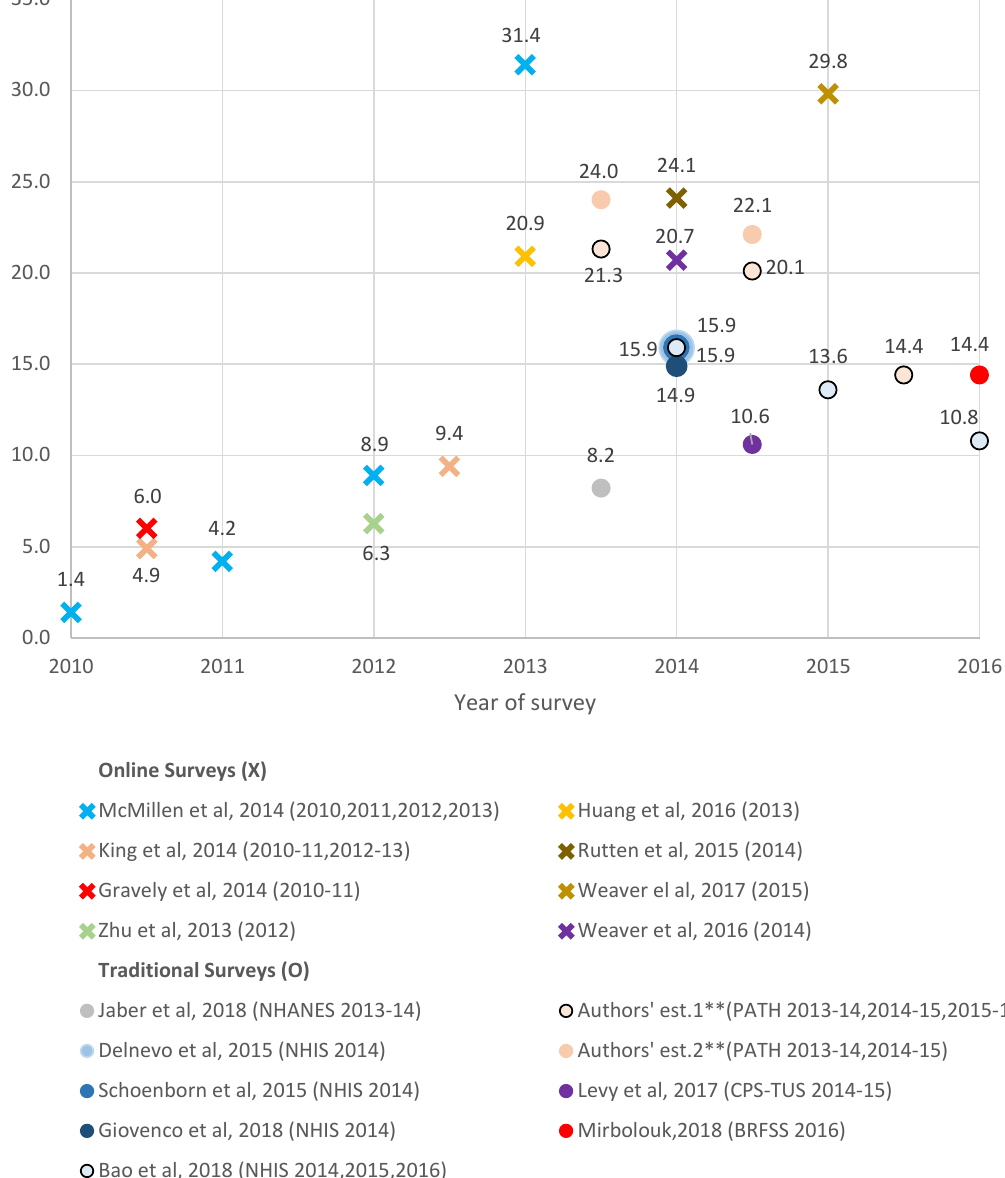
Figure 2. The prevalence of current e-cigarette / ENDS use among adult current smokers, online and traditional survey estimates *, 2010–2016. * The estimates from online surveys are indicated by an X, and the estimates from traditional surveys are indicated by a circle. The legend adopts the format “author’s name, publication year (survey name and year(s)),” and the names of all online surveys are omitted. For surveys that collected data over a two-year period, we plotted the estimates in the mid-period. ** Authors’ estimate one is measured by daily / nondaily ENDS use, and authors’ estimate two is measured by past-30-day ENDS use.